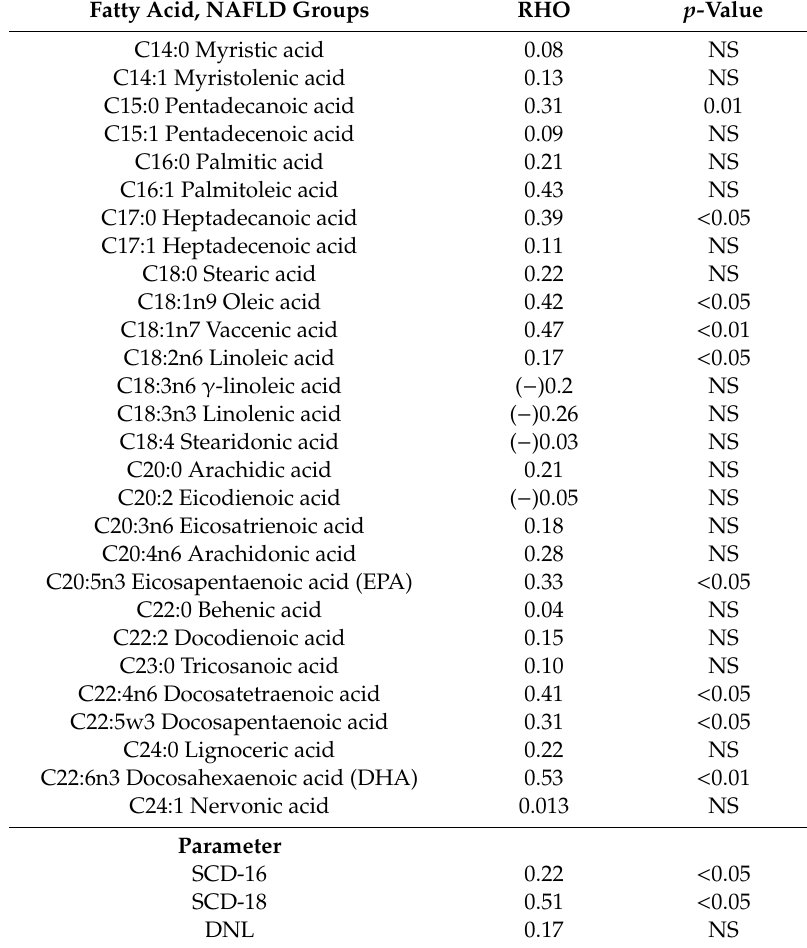
Table 3. Correlation of fatty acids between liver and blood cells in the study group. Fatty Acid, NAFLD Groups